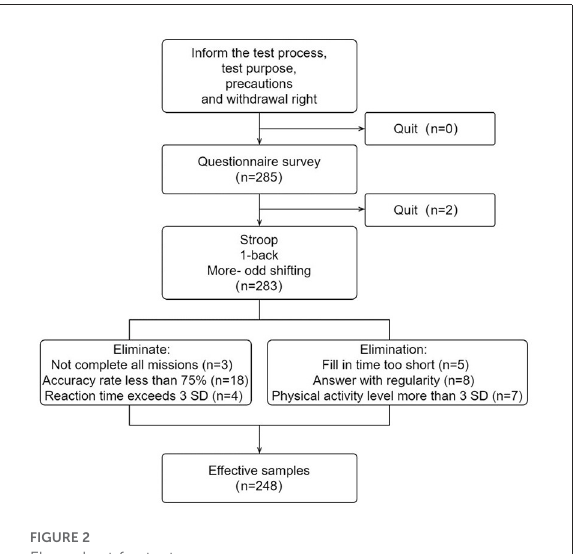
FIGURE2 Flow chart for test